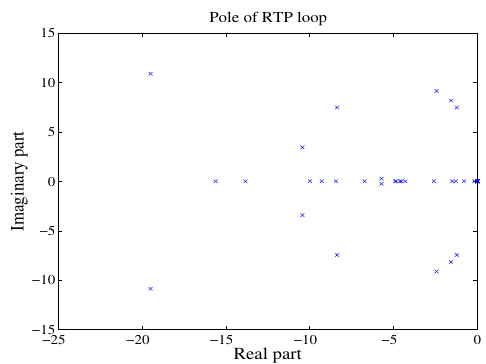
Figure 24. Pole map for the control loop of the battery 4.